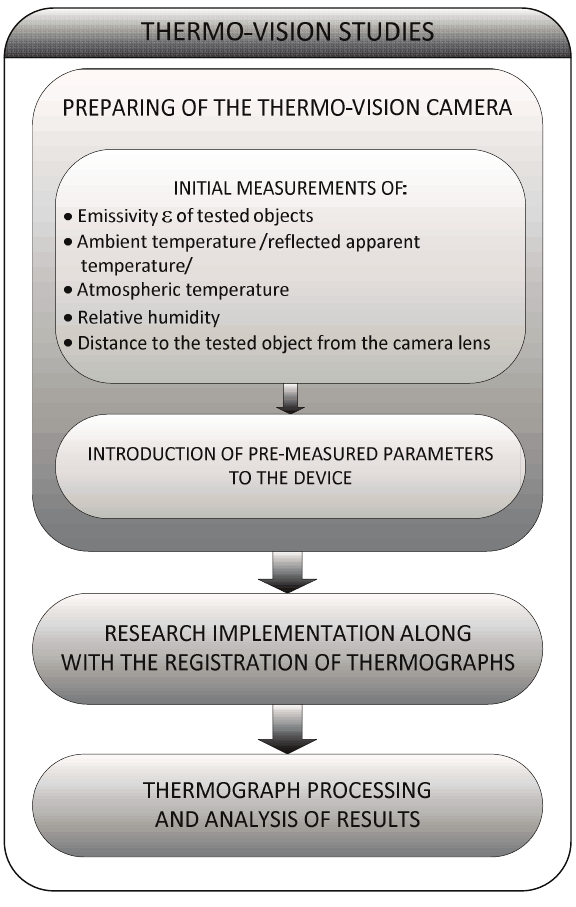
Fig. 1. Thermo-graphic measurement